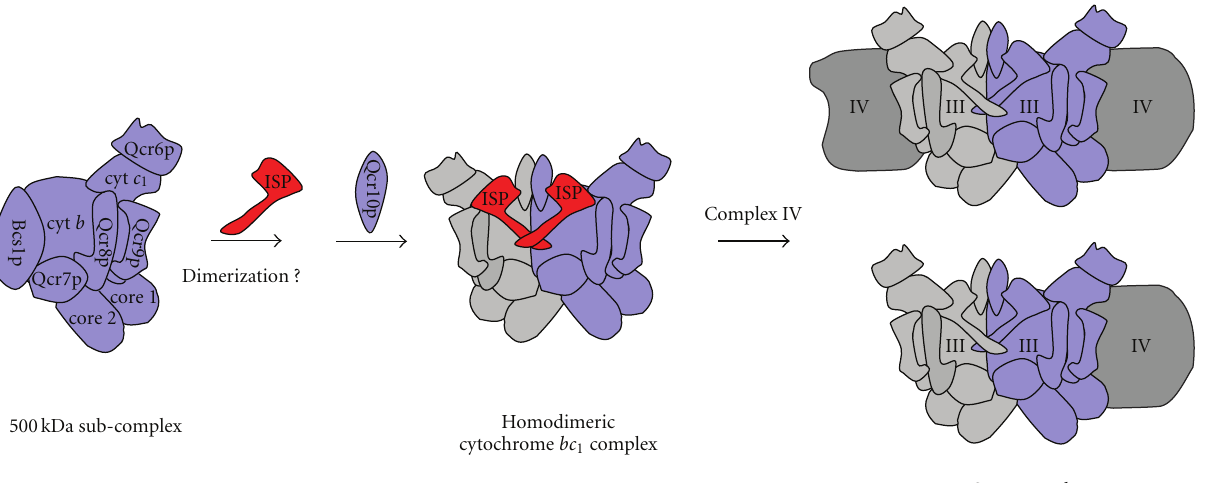
Figure 2: Schematic model depicting the last steps of assembly of the yeast cytochrome bc 1 complex. The 500kDa bc 1 subcomplex, which also includes the chaperone protein Bcs1p, sequentially binds ISP and, finally, Qcr10p, in a process which leads to the formation of the homodimeric bc 1 complex. In the final step, supercomplexes assembly involves the sequential addition of cytochrome c oxidase complex (complex IV) to homodimeric cytochrome bc 1 complex (complex